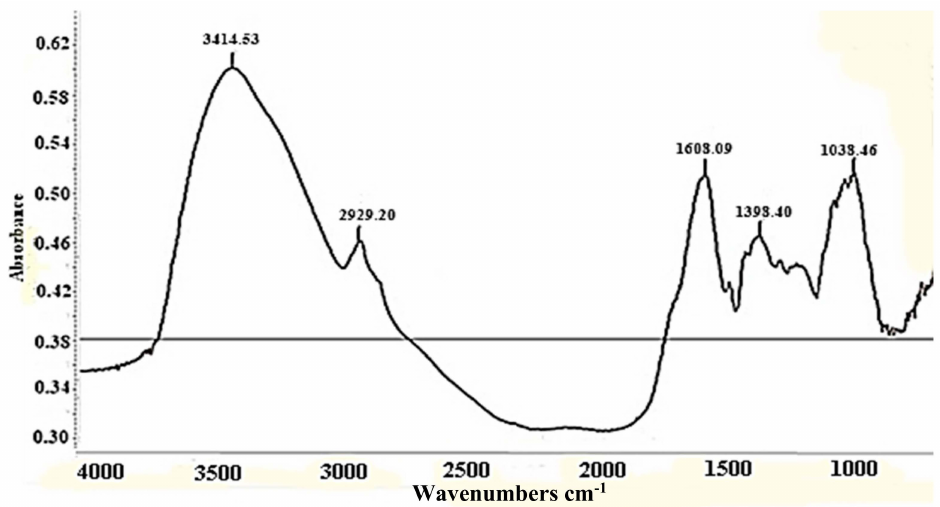
Figure 3. Fourier transform infrared spectra of aqueous bark extract.